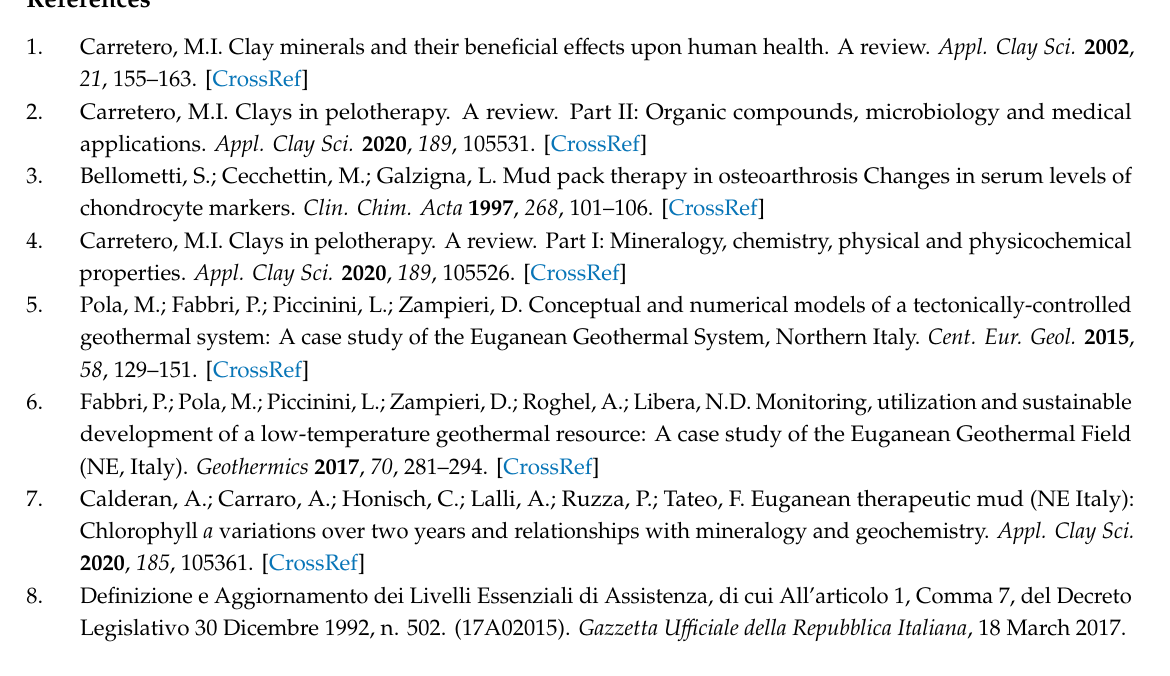
Figure S1: Artificial ponds and tanks used by Spas for mud maturation process without (A) and with protective roofs (B). Representation of a typical pond system (C). Figure S2: Average rarefaction curves (n = 2) of each sampling site (A), sequencing data and diversity parameters reported with average and standard deviations of replicates for each sampling site (B). Figure S3: Taxonomic analysis performed considering the 1471 genomes assigned to the Cyanobacteria and deposited in the NCBI microbial genome database (A). The average nucleotide identity calculated on the entire genome sequence, and represented here as a tree, shows the relationships among 76 selected Cyanobacteria species including Phormidium sp. ETS-05 (B). Figure S4: Heatmap representing the relative abundances of the OTUs assigned to Chloroflexi and having relative abundance higher than 0.5% across di ff erent temperatures and sampling sites. Figure S5: Heatmap representing the relative abundances of the OTUs assigned to the Proteobacteria and having abundance > 0.5% on total phyla. Figure S6: Heatmap reporting the relative abundances of the main OTUs (abundance > 0.5% on total phyla) of Bacteroidetes at di ff erent temperatures and sampling sites. Figure S7: Green biofilms growing on the muds surface in maturation systems provided with protective roofs (A,B), and yellow biofilms from ponds or tanks exposed to solar radiation (C,D). Figure S8: Micrographs of Phormidium sp. ETS-05 cultured at 40 ◦ C in BG11 medium. Table S1: Average values of physico-chemical parameters (n = 4) of water samples from thermal Spas in Abano, Montegrotto and Battaglia Terme in 2017 and 2018. Table S2: 16S rRNA sequences of OTUs corresponding to the most abundant